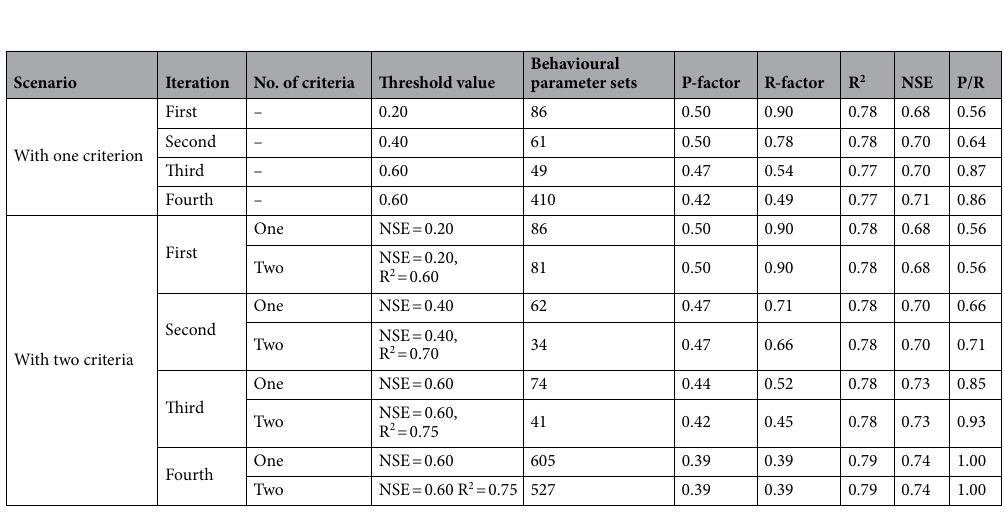
Table 3. The statistic summary of the simulation